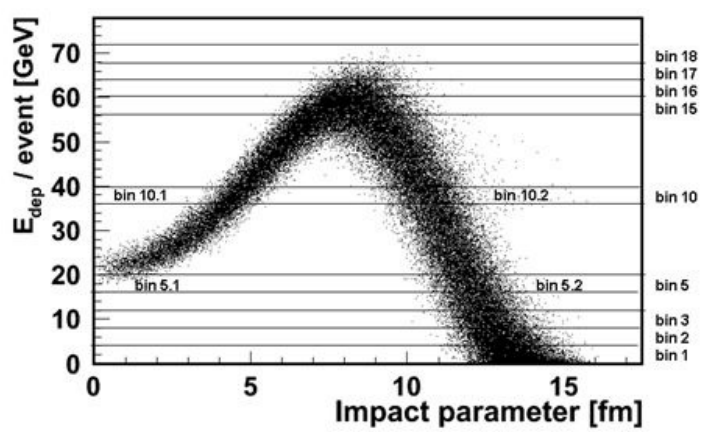
Figure 2. Dependence of total energy of spectator deposited in calorimeter on the impact parameter